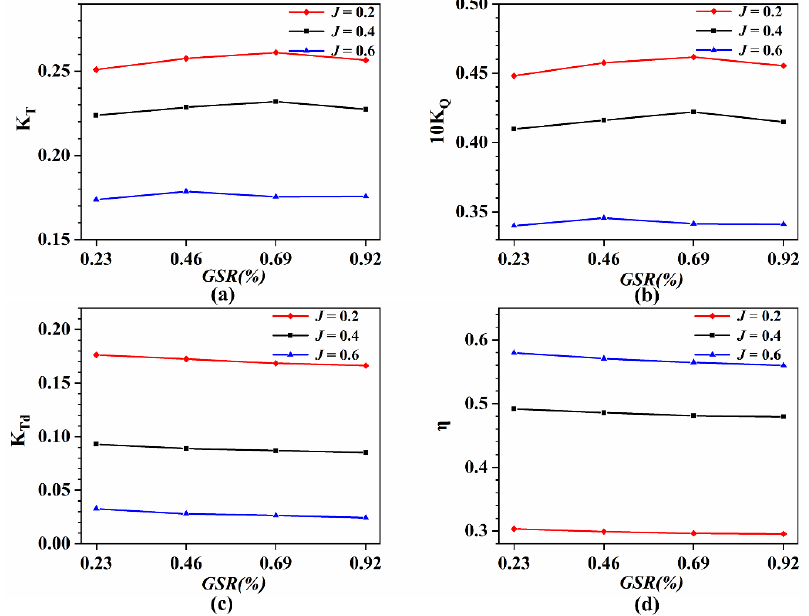
Figure 11. ( a ) Change of K T with GSR; ( b ) Change of 10K Q with GSR; ( c ) Change of K TD with GSR; ( d ) Change of η with GSR.